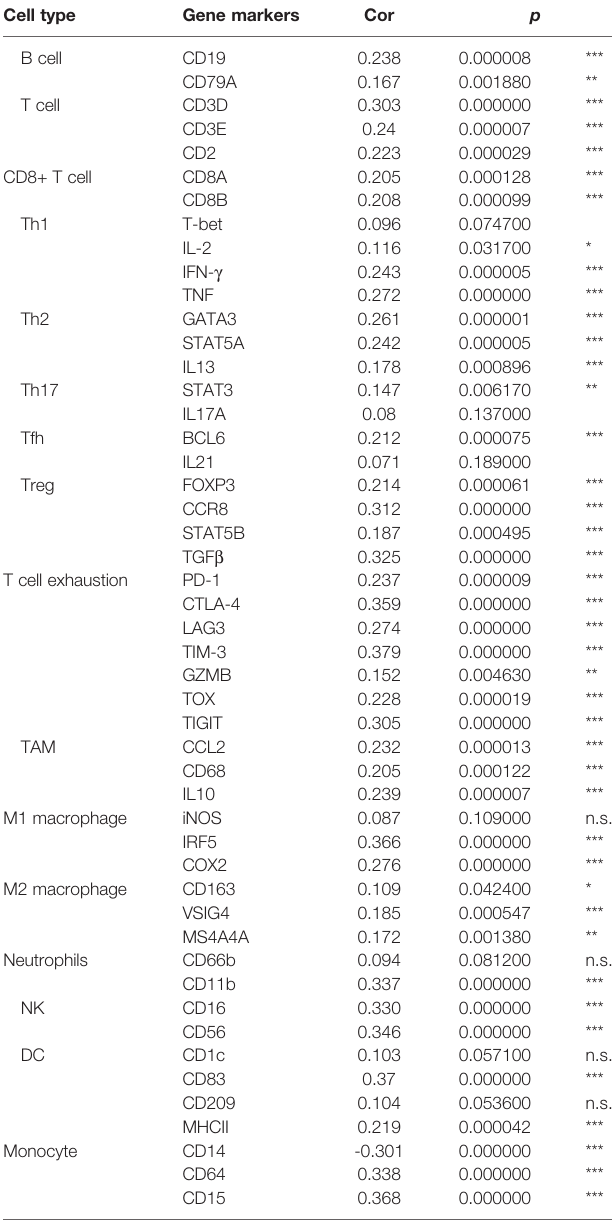
TABLE 1 | Correlation between ACYP1 expression and immune cell markers in LIHC. Cell type Gene